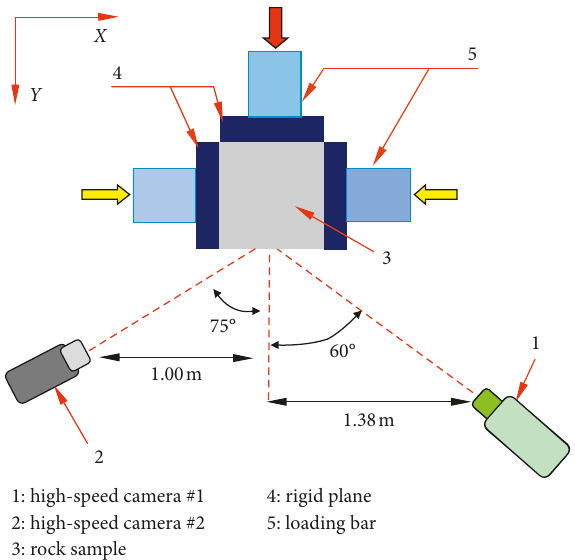
Figure 5: The arrangement of the high-speed camera system.